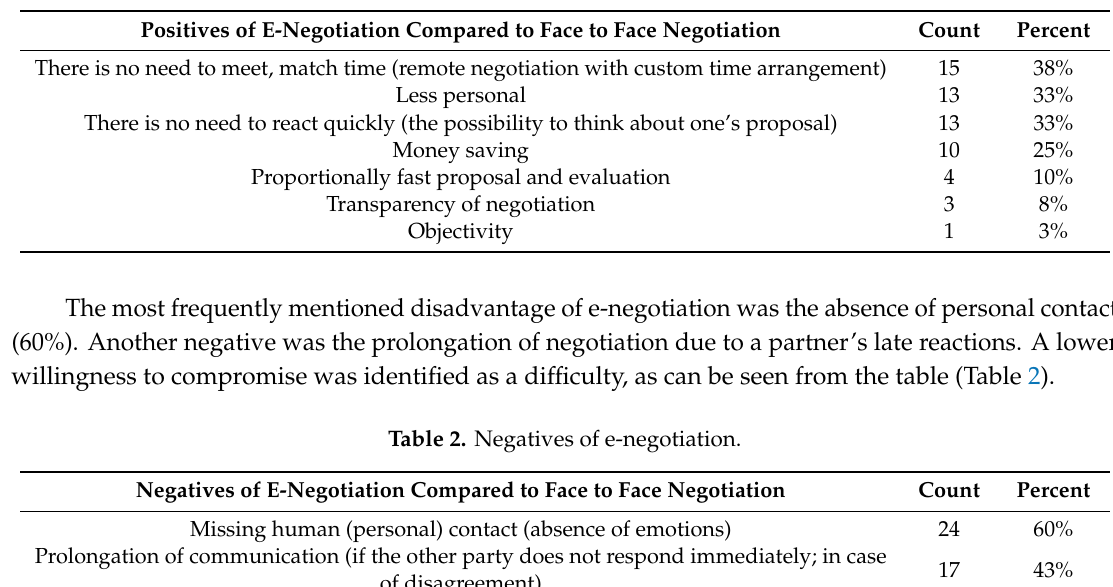
Table 1. Positives of e-negotiation.